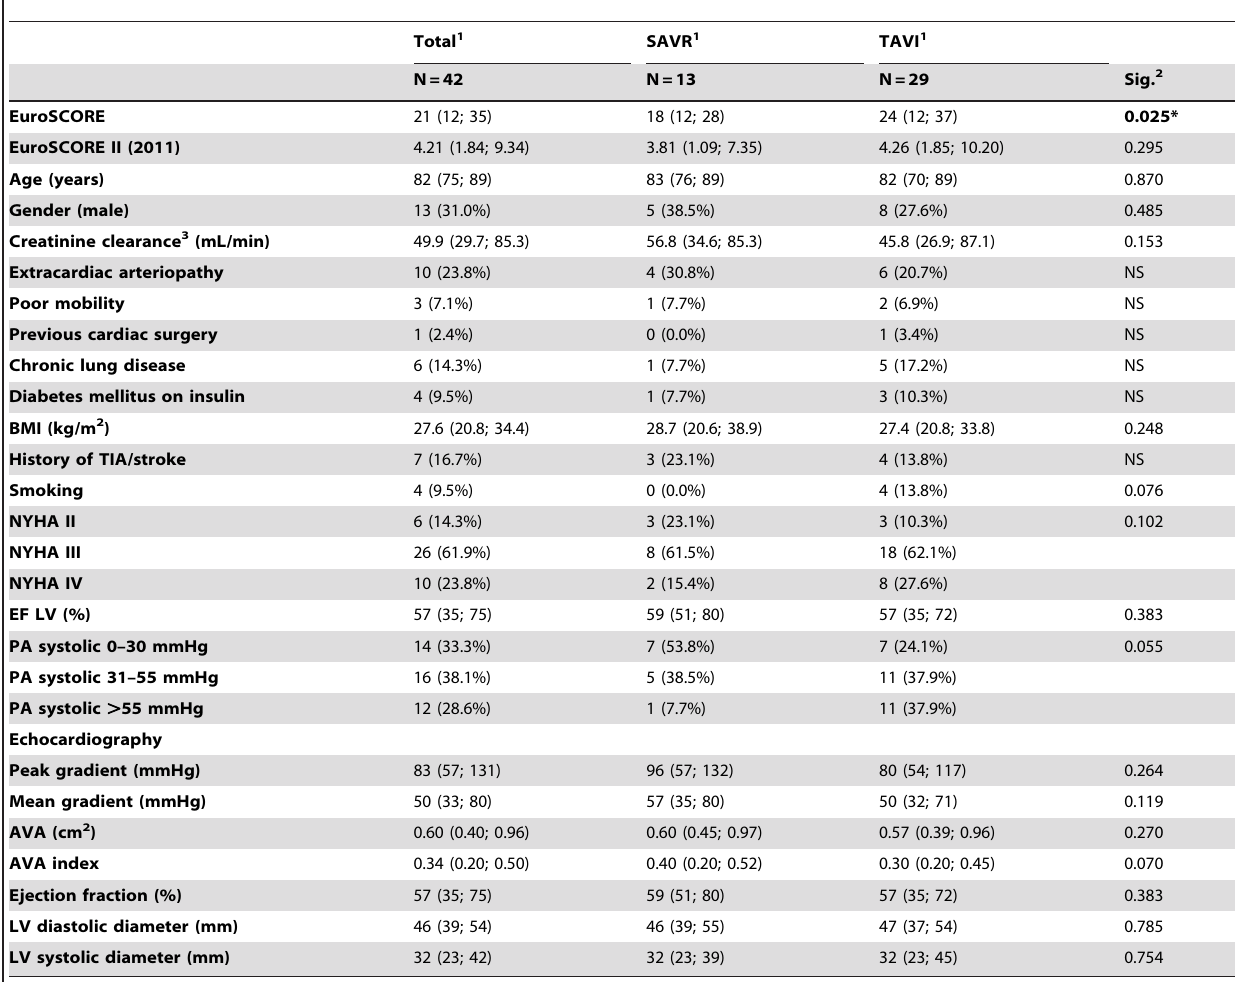
Table 1. Baseline